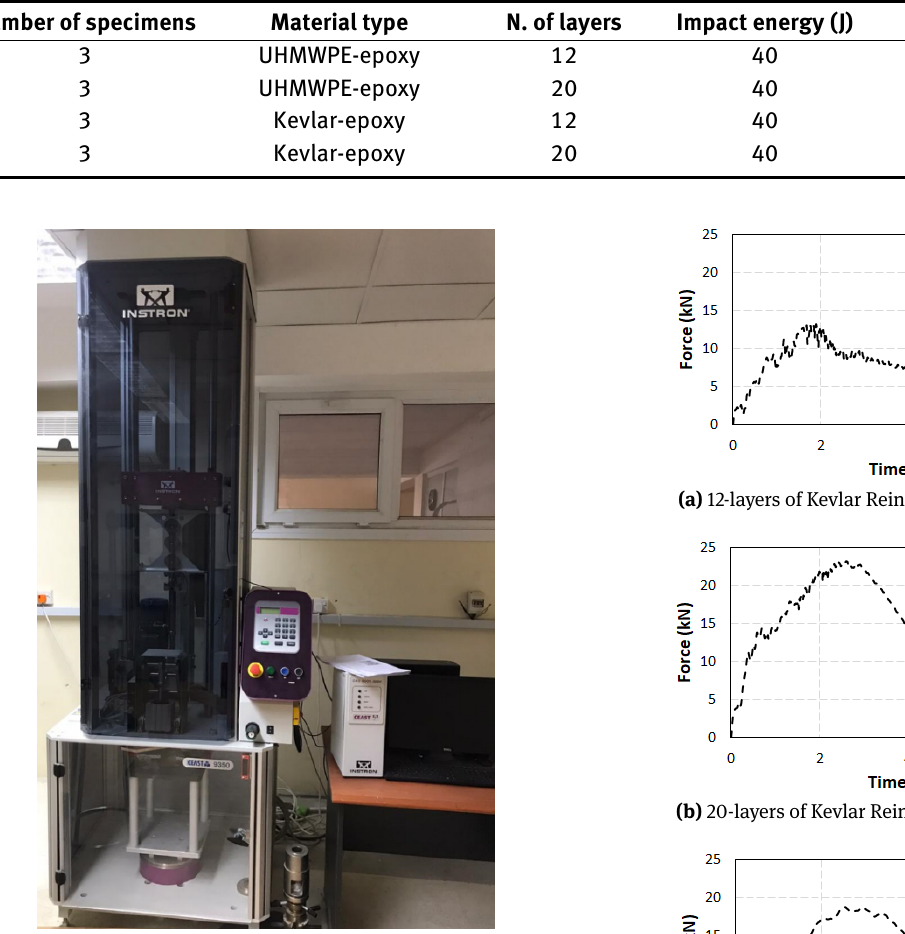
Figure 1: Drop weight impact machine